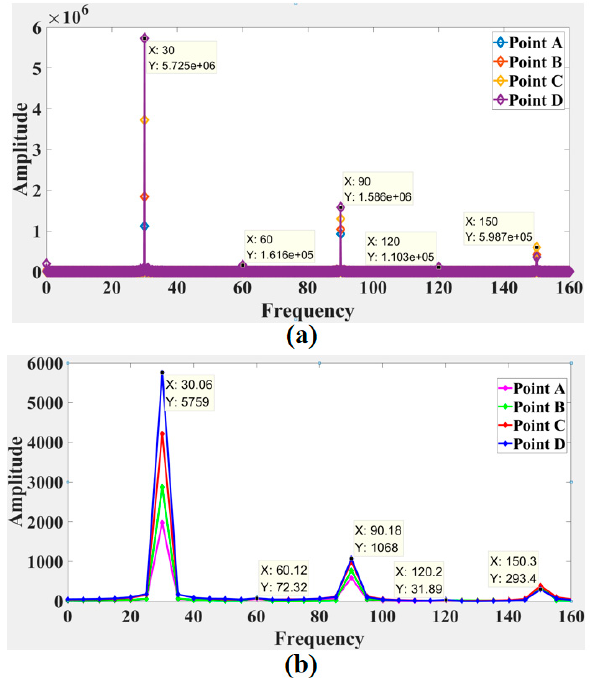
Figure 21. Comparison of the frequency spectrum obtained by ( a ) the LDV signals and ( b ) speckle patterns in the second experiment.